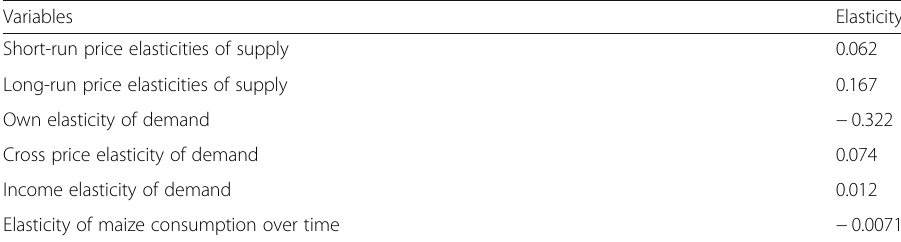
Table 4 Key findings from behavioural equations Variables